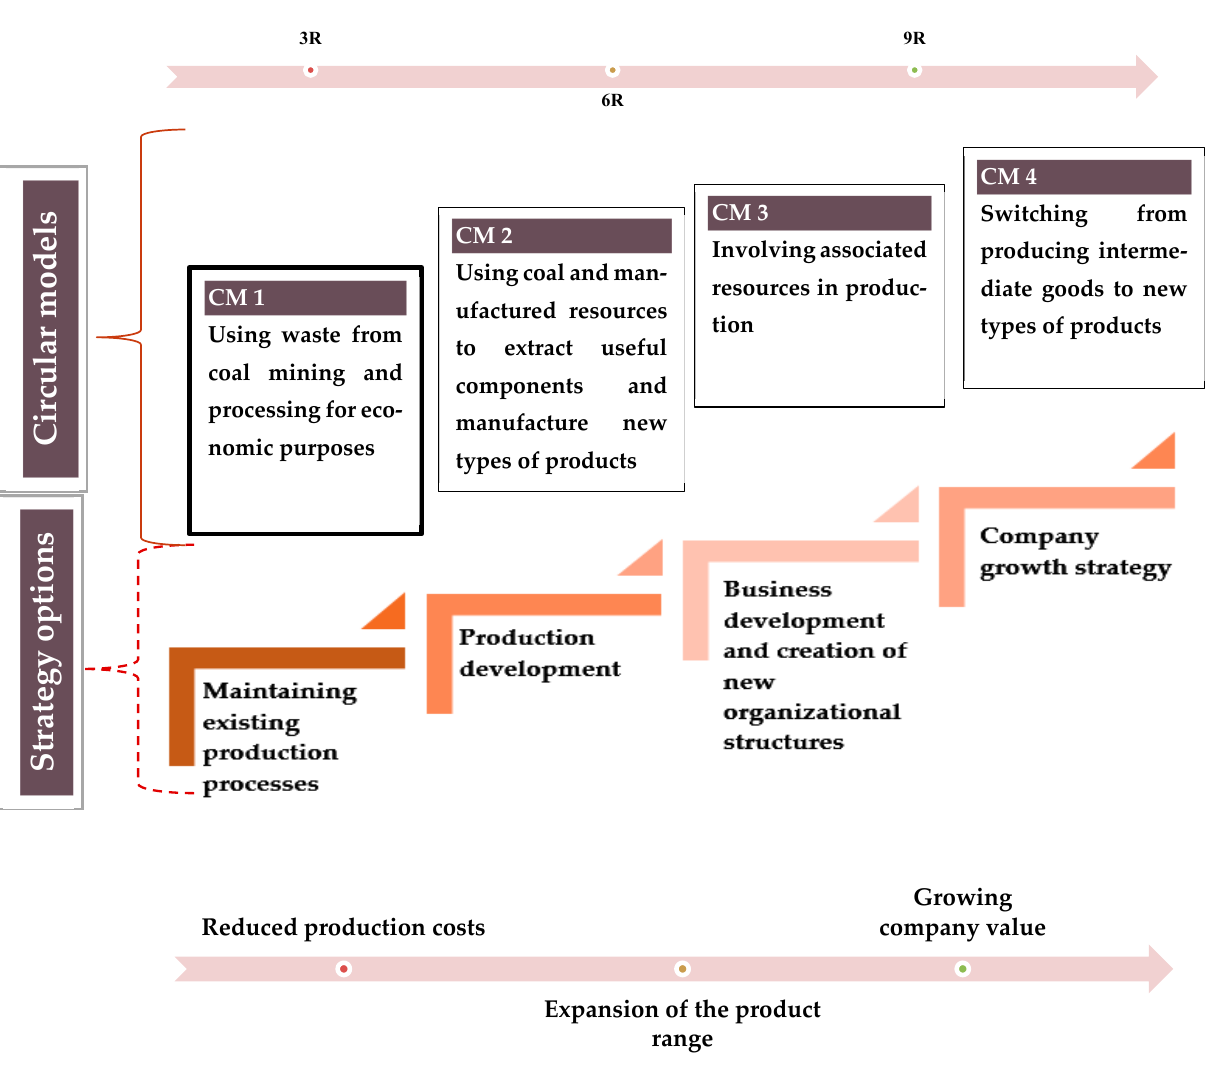
Figure 2. Diagram of the conceptual framework for developing circular business models. Source: compiled by the authors.